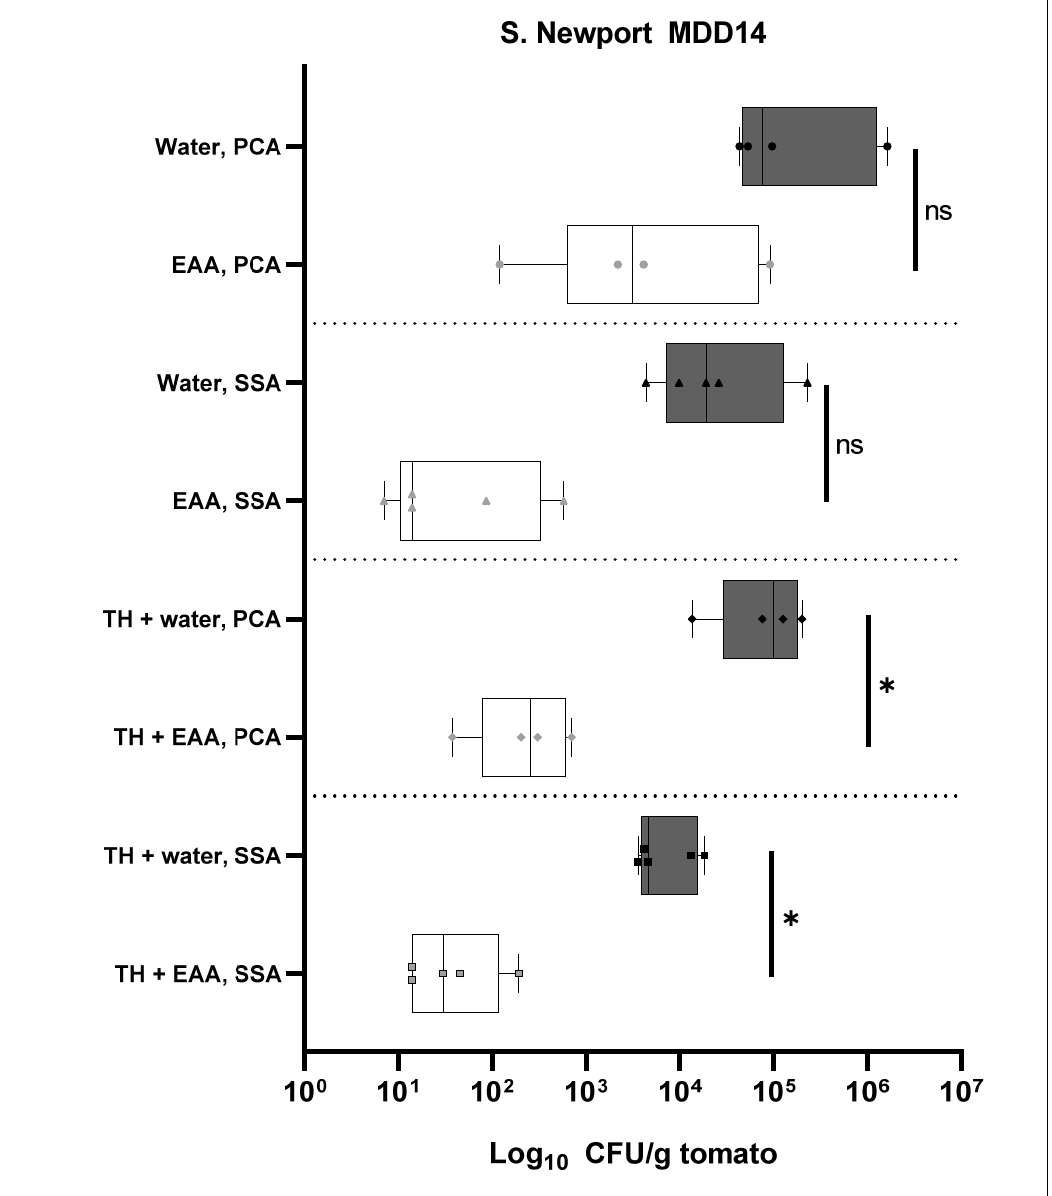
Figure 4. Effect of % tomato homogenate in the 8% EAA wash for the S. Newport MDD14 serovar. The log 10 CFU/g tomato data are plotted for each of the samples (grey bars, H 2 O; white bars, EAA). The asterisks are indicative of the significance of the p -values from the t -test (* 0.039 and 0.021, ns not significant). TH, 1% tomato homogenate was added to the 8% EAA solution or H 2 O.